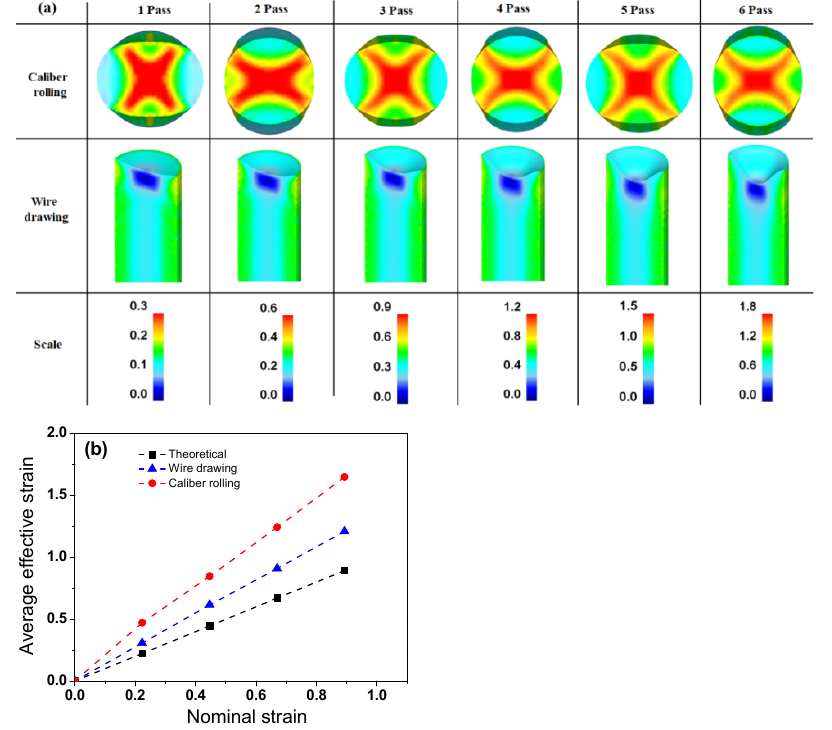
Figure 10. Comparison of the ( a ) contour maps of effective strain and ( b ) average effective strain of the drawn and caliber-rolled wires. Theoretical strain was obtained using Equation (2).